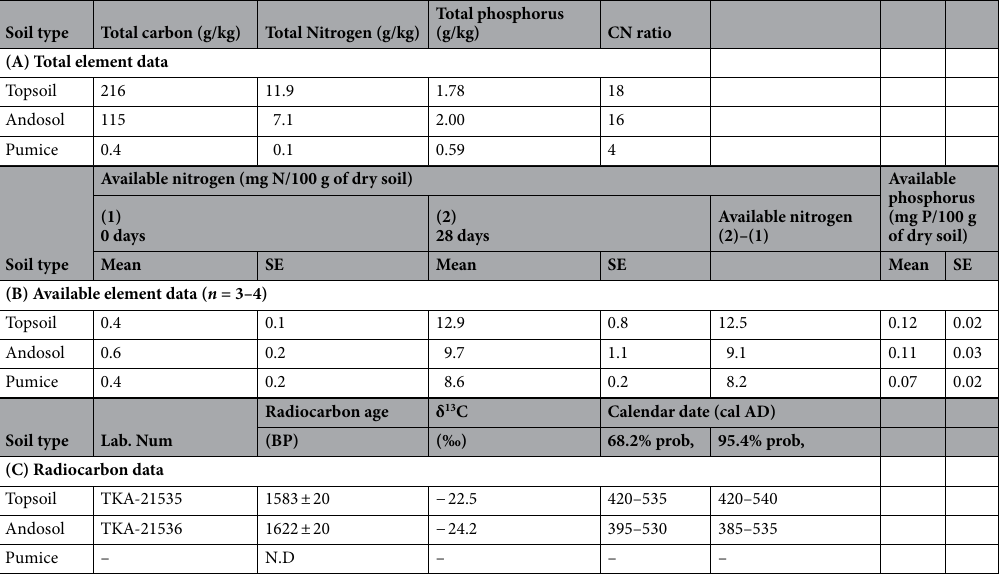
Table 3. Soil conditions for pumice, andosol, and